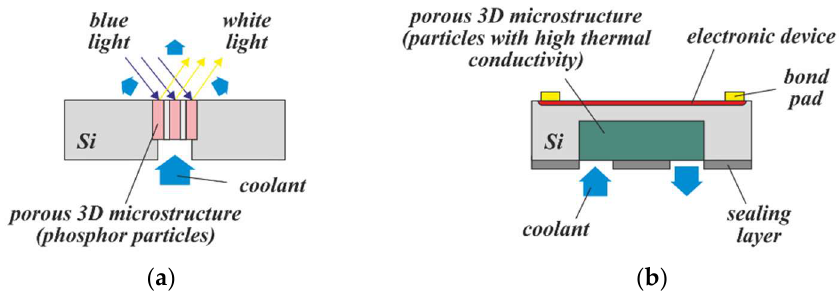
Figure 16. Concepts for actively cooled MEMSs: A coolant is forced through ( a ) a porous luminescence converter, manufactured from phosphor particles, and ( b ) a porous 3D microstructure, manufactured from particles with high thermal conductivity, which is embedded in a Si chip with a heat-generating electronic